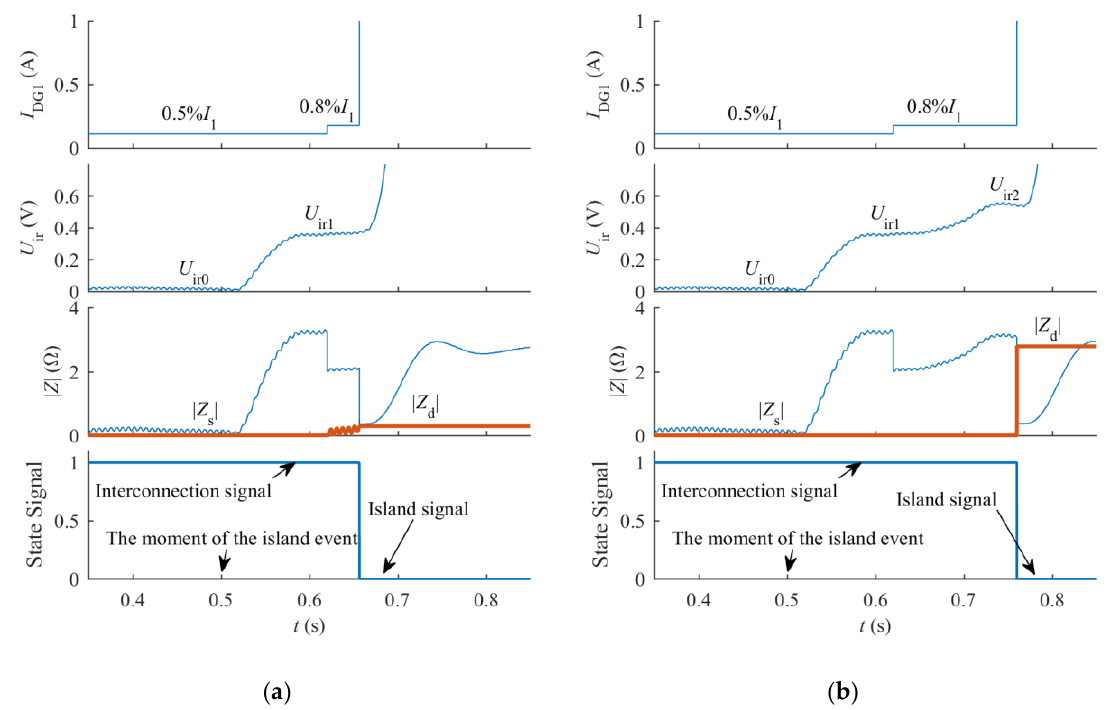
Figure 8. Island event occurring. ( a ) Continuously measuring | Z d | after the command of increasing I DG1 is issued; ( b ) Measuring | Z d | until U ir is stable at U ir2 .